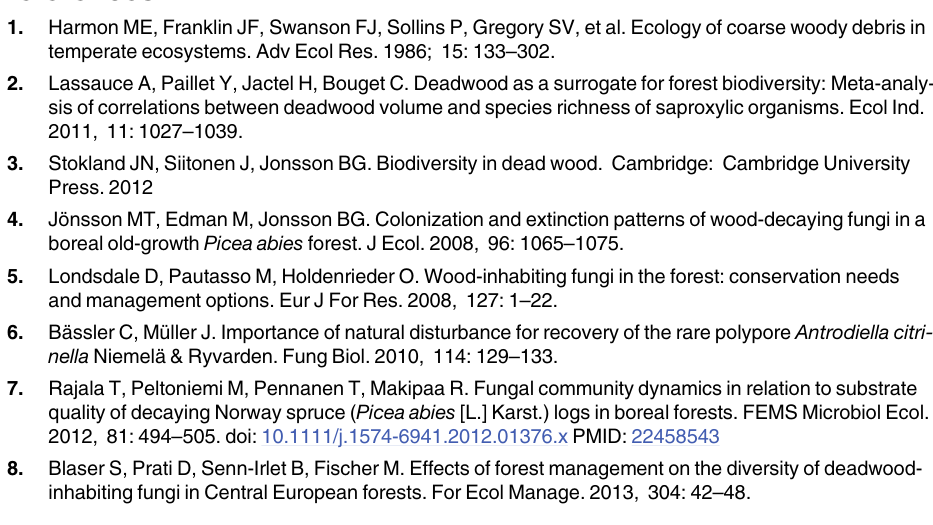
S3 Fig. Icicle-like adjaceny chart: made with in-cell bars representing the taxonomic distri- bution of the fungal sequences and MOTUs found as well as the plots where these MOTUs were found (heatmapped by number of sequences). (A) quantiles, sum of sequences in MOTU, MOTU name, MOTU reference sequence accession number, icicle chart based on abbreviated NCBI taxonomy path, ecological information, (B) in addition, clone origin of MOTU reference sequence,nearest BLASTn hit accession number, length of MOTU reference sequence, and distribution of MOTUs across samples. S4 Fig. Individual based rarefaction curves with confidence intervals computedfor all com- bined wood-inhabiting fungi (left) and beetles (right). Due to little species overlap between regions sampling was not representative. Beetle but not fungal richness differed significantly between